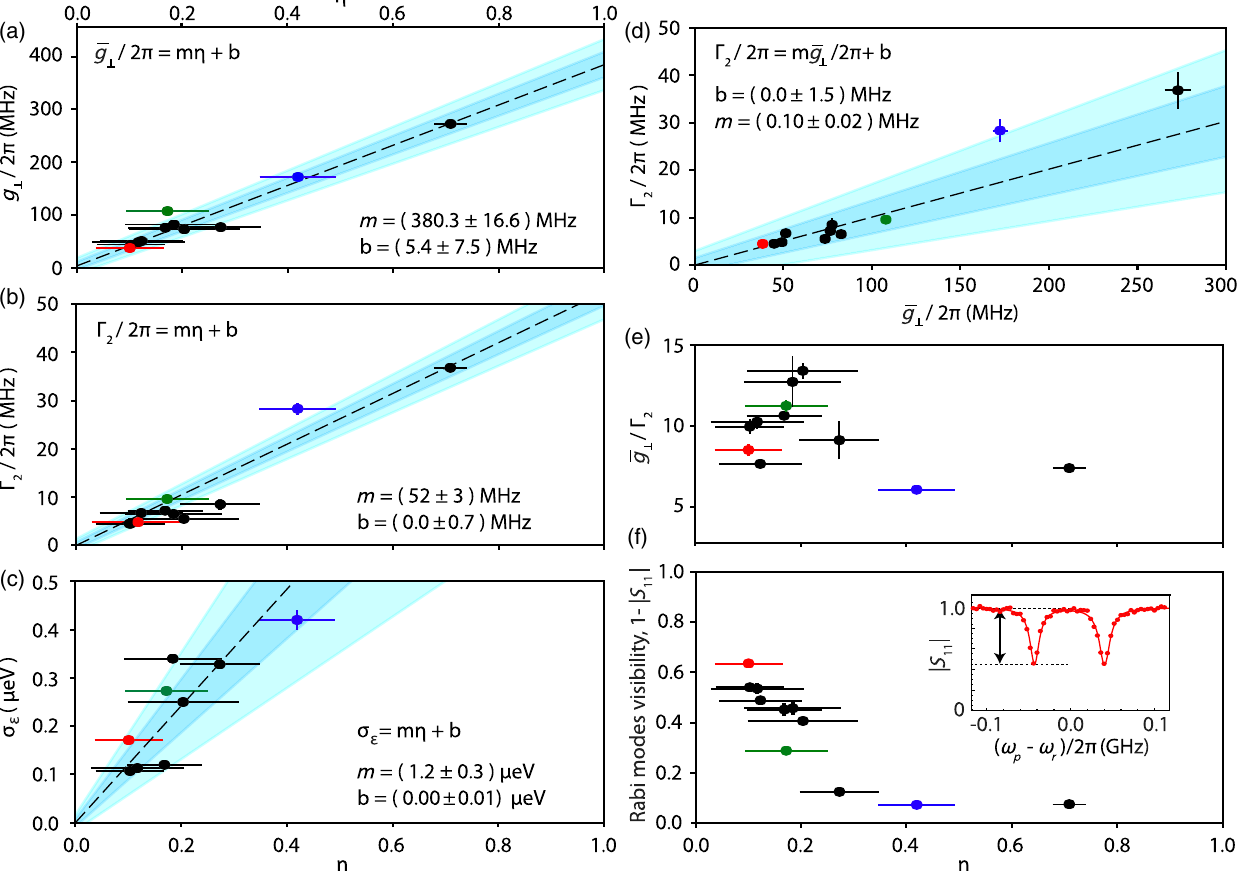
FIG. 4. Coupling strength and decoherence parameters extracted for 11 DQD gate bias voltage configurations. (a) Normalized coupling ¯ g ⊥ [see Eq. (12)] of the DQD charge qubit to the resonator versus the dipole strength η . (b) Qubit linewidth Γ 2 versus η . The linewidth is extracted as in Fig. 3(e). (c) Effective detuning noise of the DQD charge qubit σ ϵ versus η , obtained as in Fig. 3(f). For two configurations in correspondence with η ¼ 0 . 123 and 0.709, we cannot extract σ ϵ due to either spurious resonances or enhanced sensitivity to detuning noise, respectively. (d) DQD linewidth Γ 2 versus the normalized coupling. The data in (a) – (d) are fitted to a linear model plotted as dashed lines, and the fit parameters are stated in the panels. The dark [light] blue area represents the one- [two-]sigma confidence interval. (e) The quality factor ¯ g ⊥ = Γ 2 versus η . (f) Visibility of the vacuum Rabi modes (at resonance) ð 1 − j S 11 jÞ ¼ 2 κ κ 2 Γ η . The inset shows an example of a vacuum Rabi mode splitting, with the black arrow indicating the = ð κ 2 Þ versus ext ext þ int þ visibility of a Rabi mode at the